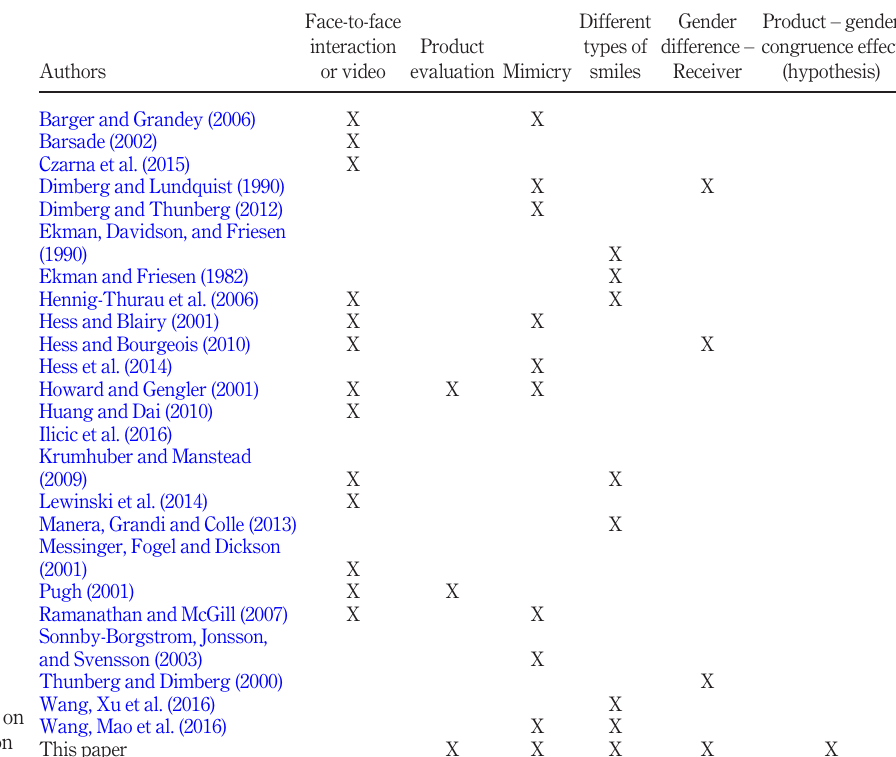
Table I. Previous literature on emotional